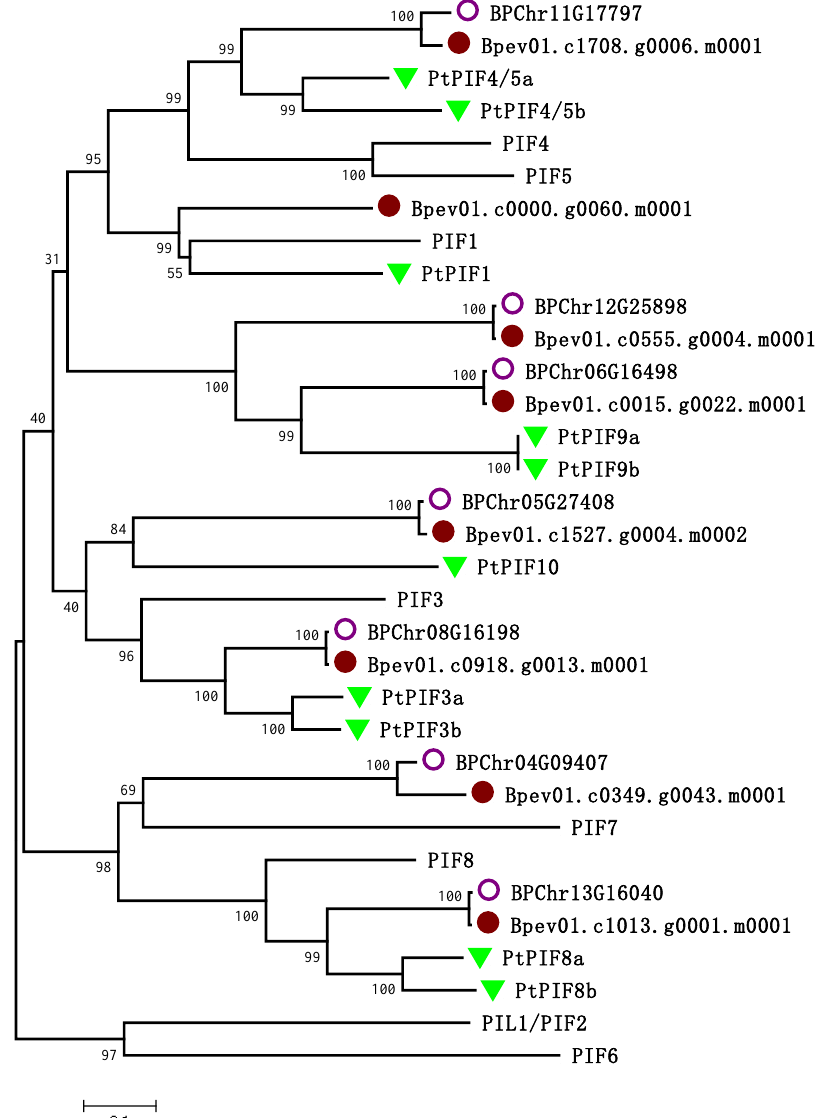
Figure 1. The evolutionary history was inferred using the neighbour-joining method. Then, the phylogenetic tree was constructed based on the full-length protein sequences of BpPIFs, 8 AtPIF, and 10 PtPIF proteins using MEGA 7.0 software (available online: https://www.megasoftware.net/, accessed on 29 August 2021).